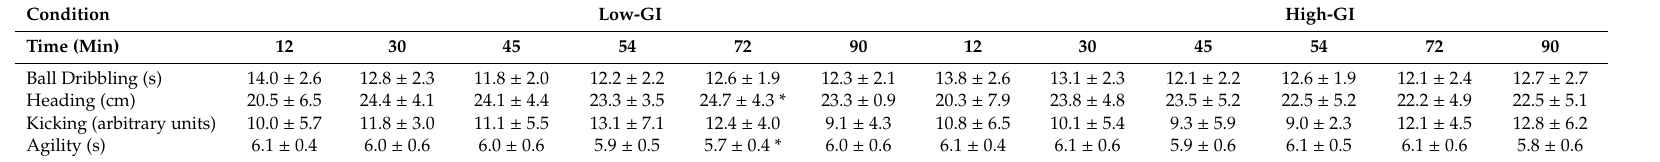
Table 2. Performance variables during the simulated soccer